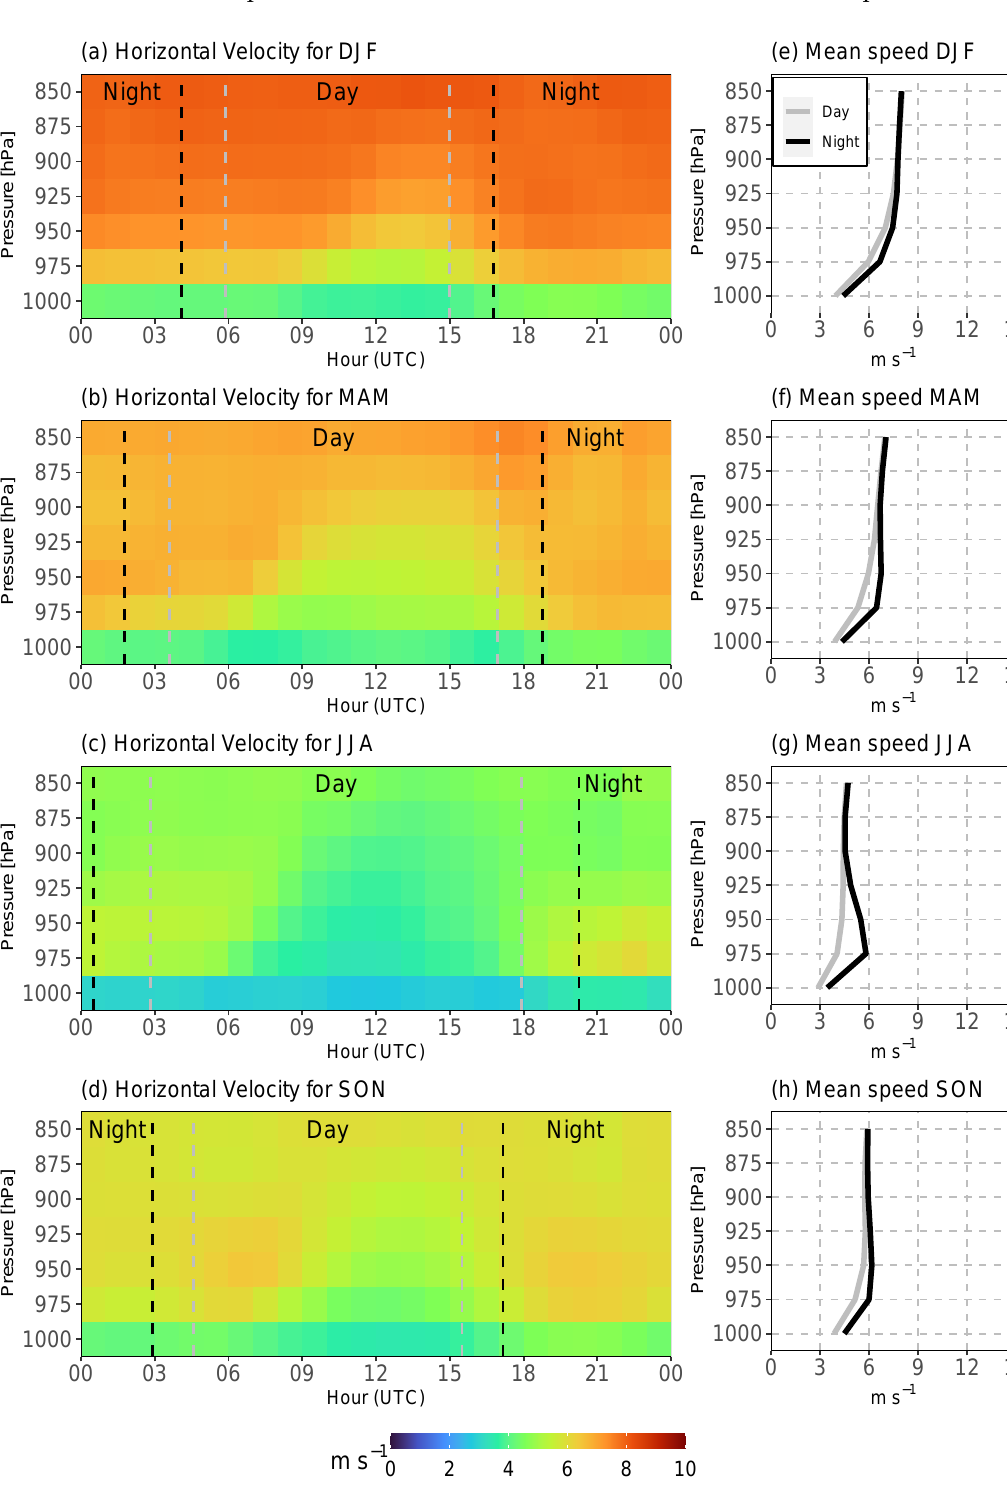
Figure 7. ERA5 hourly means of horizontal wind speeds for December 2019–November 2021 analysed period for all seasons ( a – d ) and the mean speed profiles for daytime and nighttime ( e – h